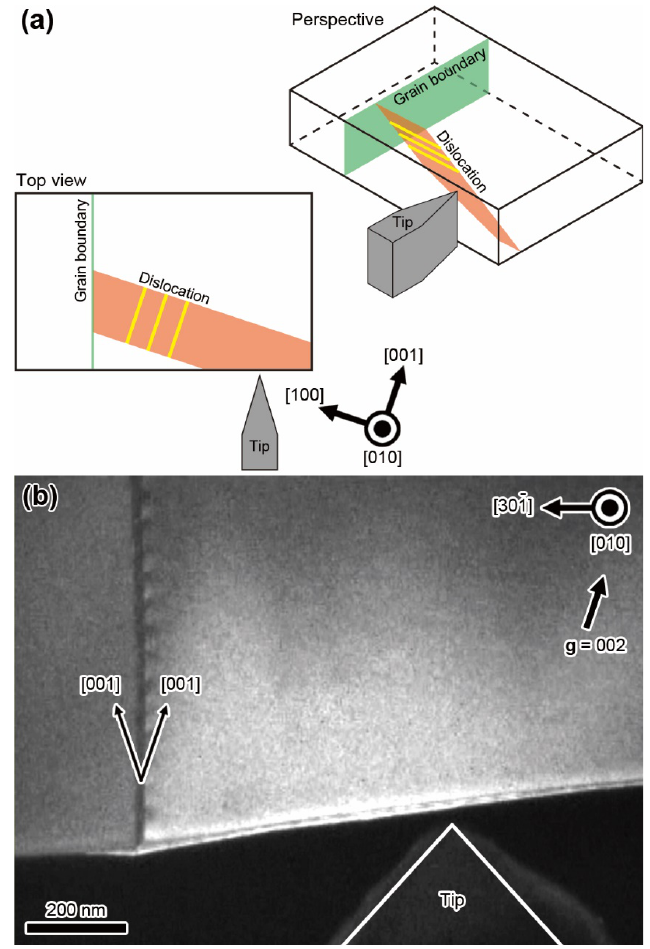
Figure 72. ( a ) Schematic illustration showing the geometric arrangement of the specimen, the [010](301) Σ 5 grain boundary, the indenter tip, and the introduced lattice dislocation; ( b ) A dark-field TEM image just before the nanoindentation experiment. The weak triangular contrast at the lower right is the indenter tip and the vertical line contrast inside the specimen corresponds to the grain boundary. The sample thickness is estimated to be about 300 nm. Adapted with permission from Ref. [276].